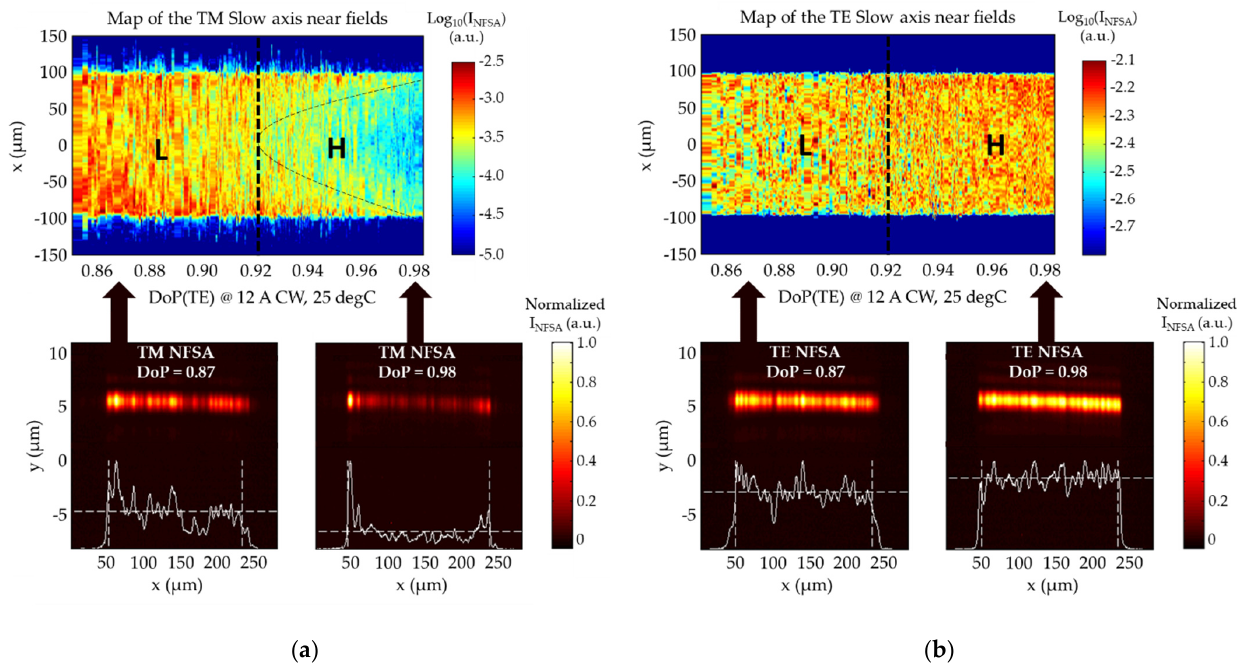
Figure 11. Measurement of 324 mounted HPLD: ( a ) TM-polarized NFSA; ( b ) TE-polarized NFSA. For mainly TE-polarized compressively strained-QW HPLD, the TM-polarized NFSA represents a distribution of the mechanical stress on the device and can be very useful in the development of high-DoP HPDL, by optimizing chip dielectrics, metals, shape, mounting process, and carrier structure. Given that mechanical stress is an effect of the randomly changing technological conditions within a statistical process control, a